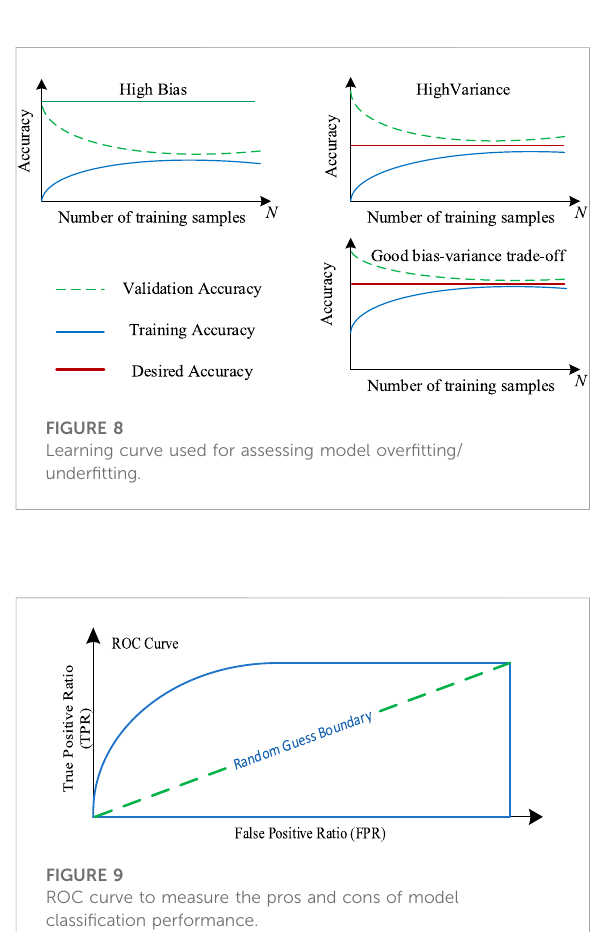
FIGURE 9 ROC curve to measure the pros and cons of model classi fi cation performance.